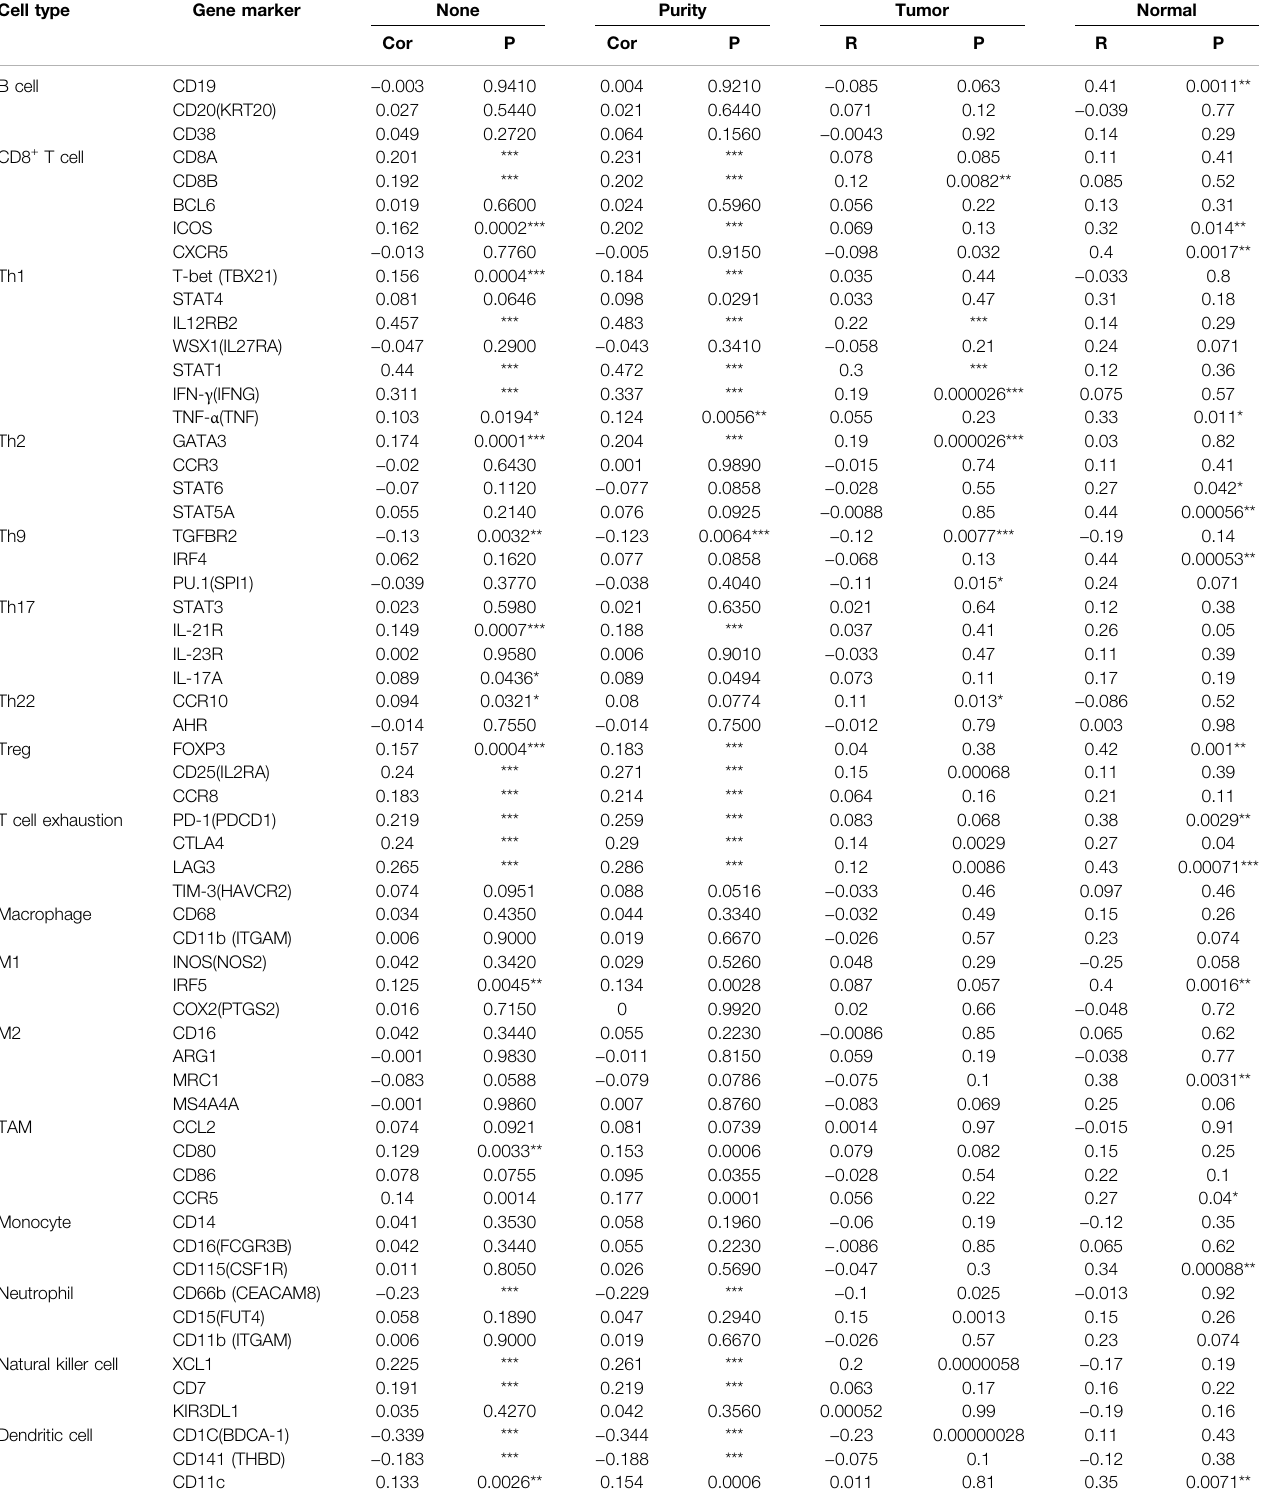
TABLE 2 | Correlation between FANCD2 levels and markers of immune cells based on TIMER and GEPIA databases. Cell type Gene marker